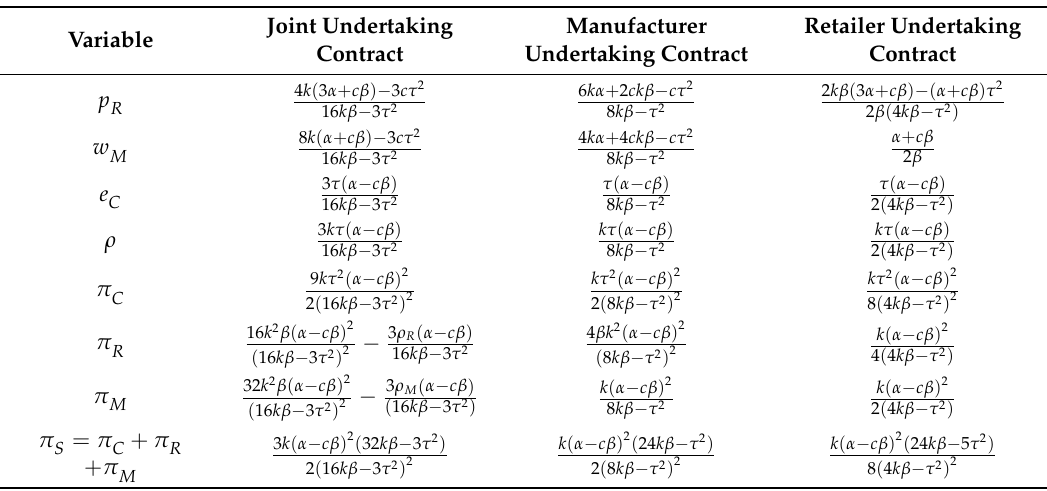
Table 2. The results in three undertaking